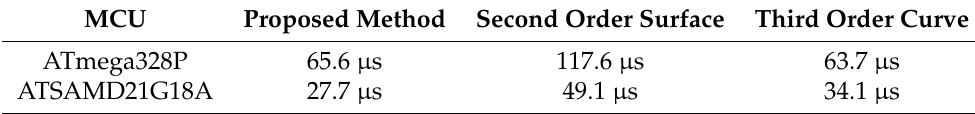
Table 11. Computing time for the compensation methods in different